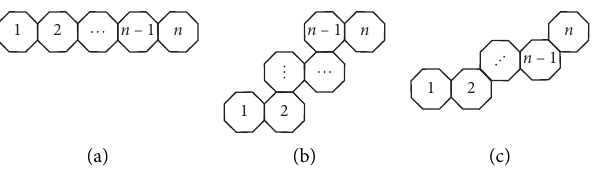
Figure 5: The parachain P